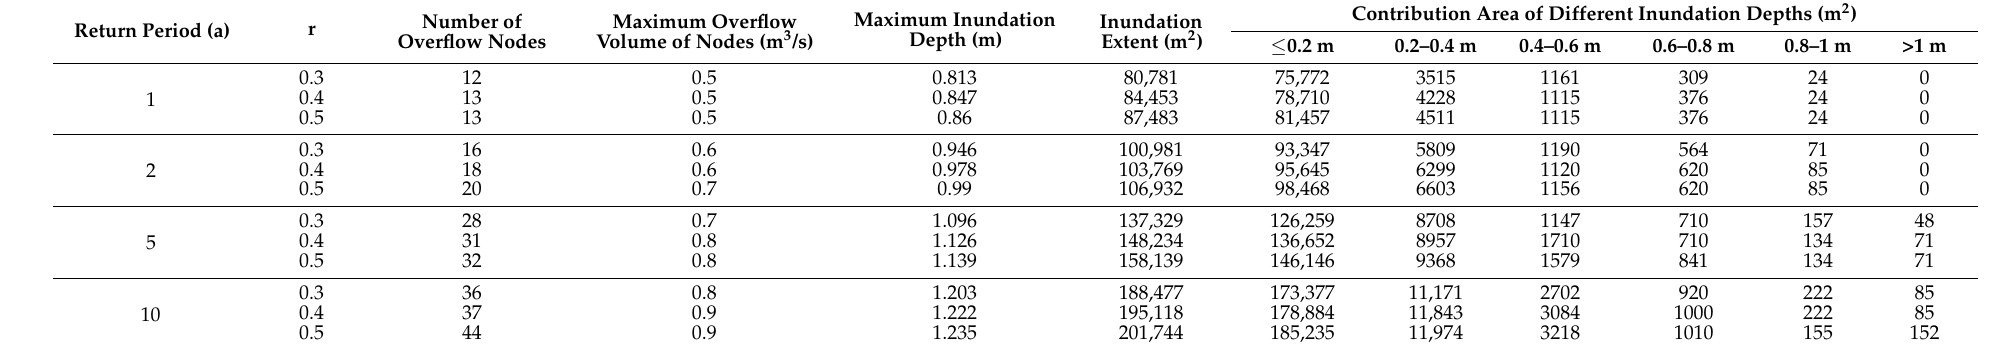
Table 5. The inundation depths and extents in the study area under different designed rainfall scenarios ( t = 120